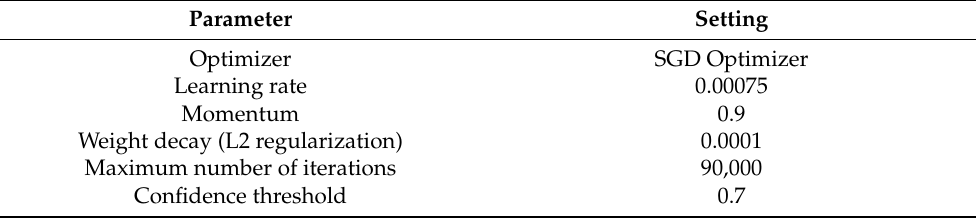
Table 1. The details of the optimizer and hyperparameters for our proposed